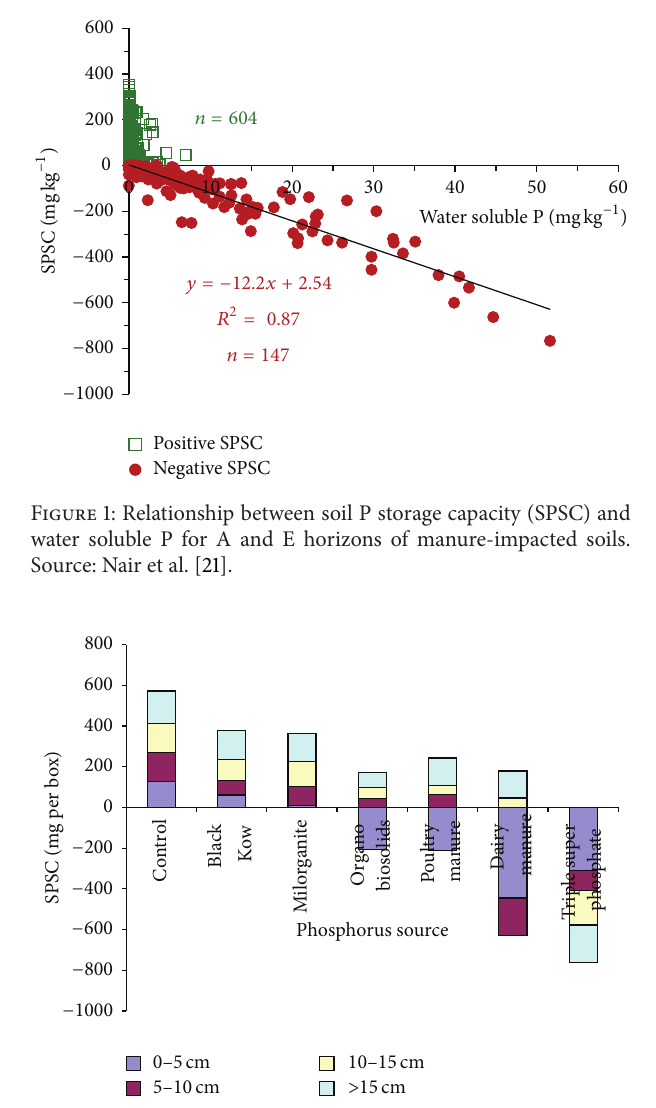
Figure 2: Soil phosphorus storage capacity (SPSC) differences by depth for various P sources Black Kow compost, Milorganite biosolid, Orlando biosolid, poultry and dairy manure, and inorganic fertilizer (triple superphosphate) applied at the same total P concen- trations(9gperbox),comparedtothecontrolwithnoPadditionsin a laboratory rainfall simulation experiment. Source: Rew et al.